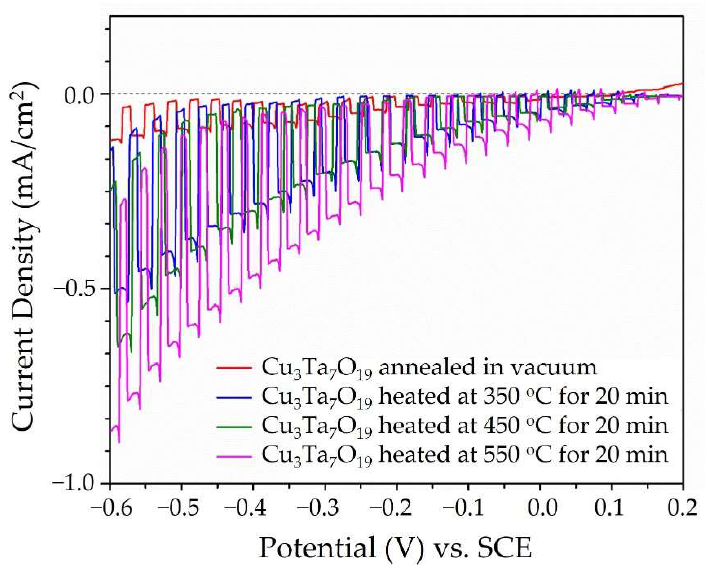
Figure 4. Current density as a function of applied potential versus the standard calomel electrode (SCE) in an aqueous 0.5M Na 2 SO 4 solution at pH ~ 6.3 under chopped visible light irradiation for Cu 3 Ta 7 O 19 films annealed in a vacuum at 500 °C, and after heating in air for 20 min at 350 °C (blue), 450 °C (green), and at 550 °C (magenta).